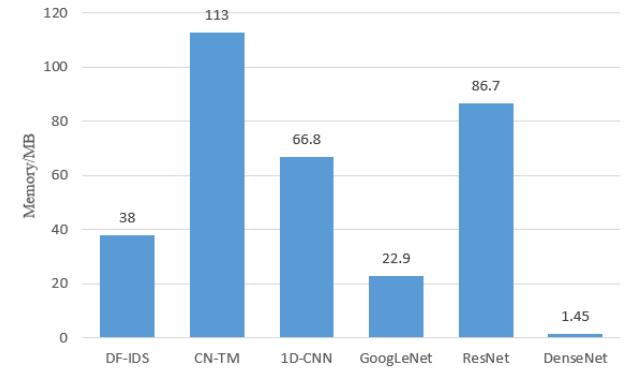
Figure 9. Comparison of RAM occupied by models.